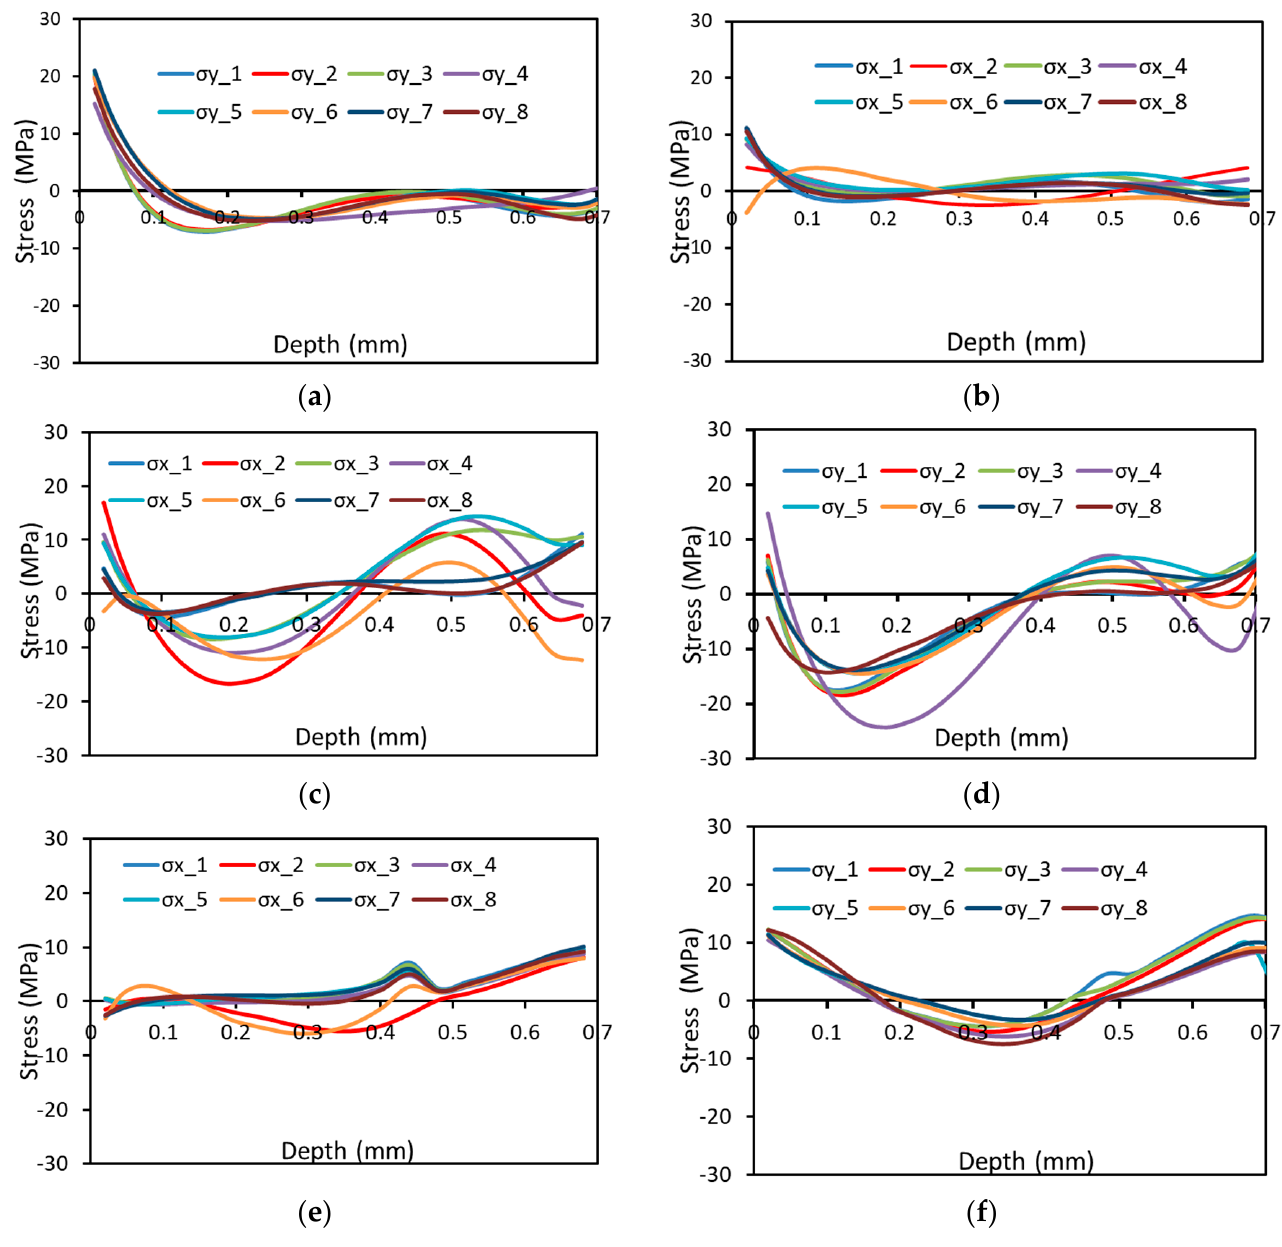
Figure 11. Depth ‐ dependent residual stresses σ x ( a , c , e ) and σ y ( b , d , f ) of CFRP with thickness of 3 mm ( a , b ), 2 mm ( c , d ), and 1 mm ( e , f ), respectively.